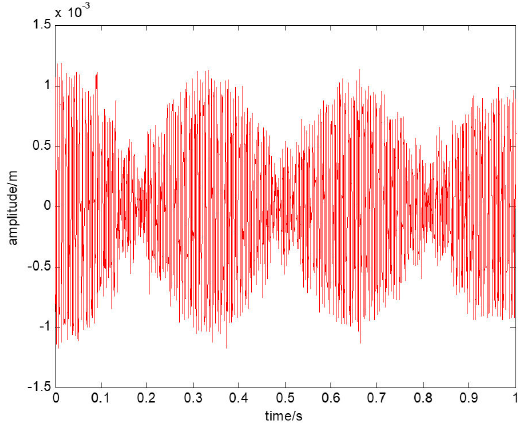
Figure 15. Horizontal displacement response.